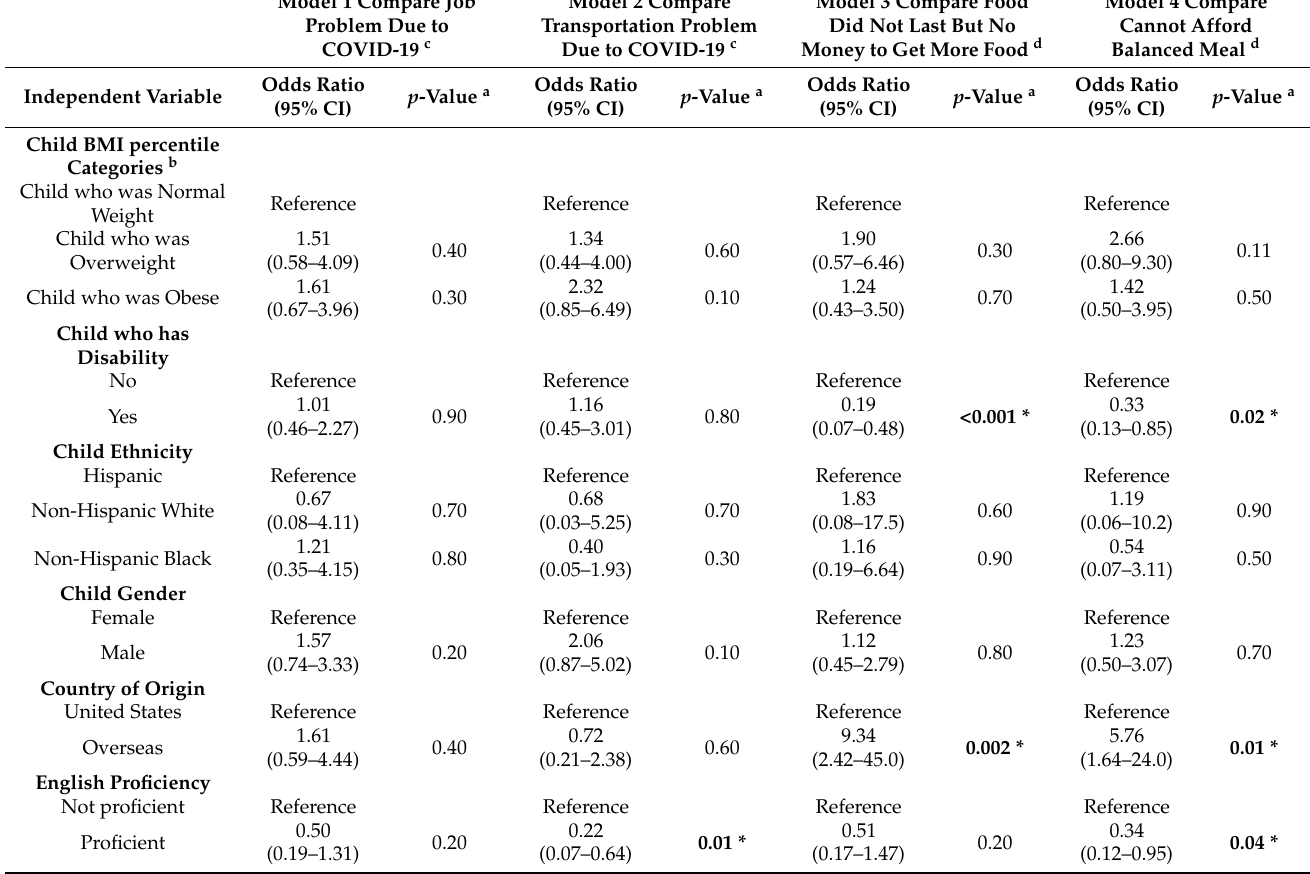
Table 4. Multivariable Logistic Regression Models to Compare COVID-19-Related Outcomes in Child BMI Percentile Categories, Controlling for Disability Status, Child Ethnicity, Child Gender, Country of Origin, and English